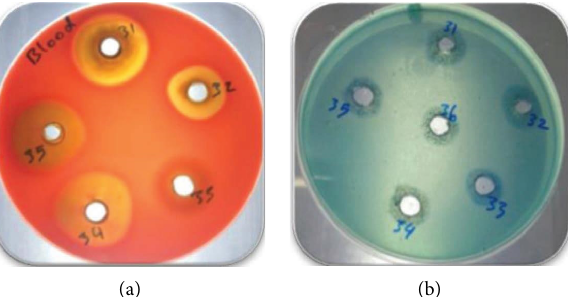
Figure 1: Primary screening of bacterial isolates. β -Hemolysis of blood agar medium (a) and bluish halo zone of blue agar medium (b) were considered positive results.